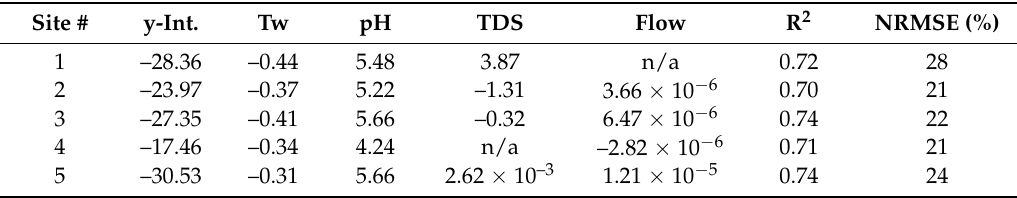
Table 6. Predictive dissolved oxygen (DO) (mg L − 1 ) models and performance statistics ( n = 766) for each gauging site in Hinkson Creek Watershed, MO,